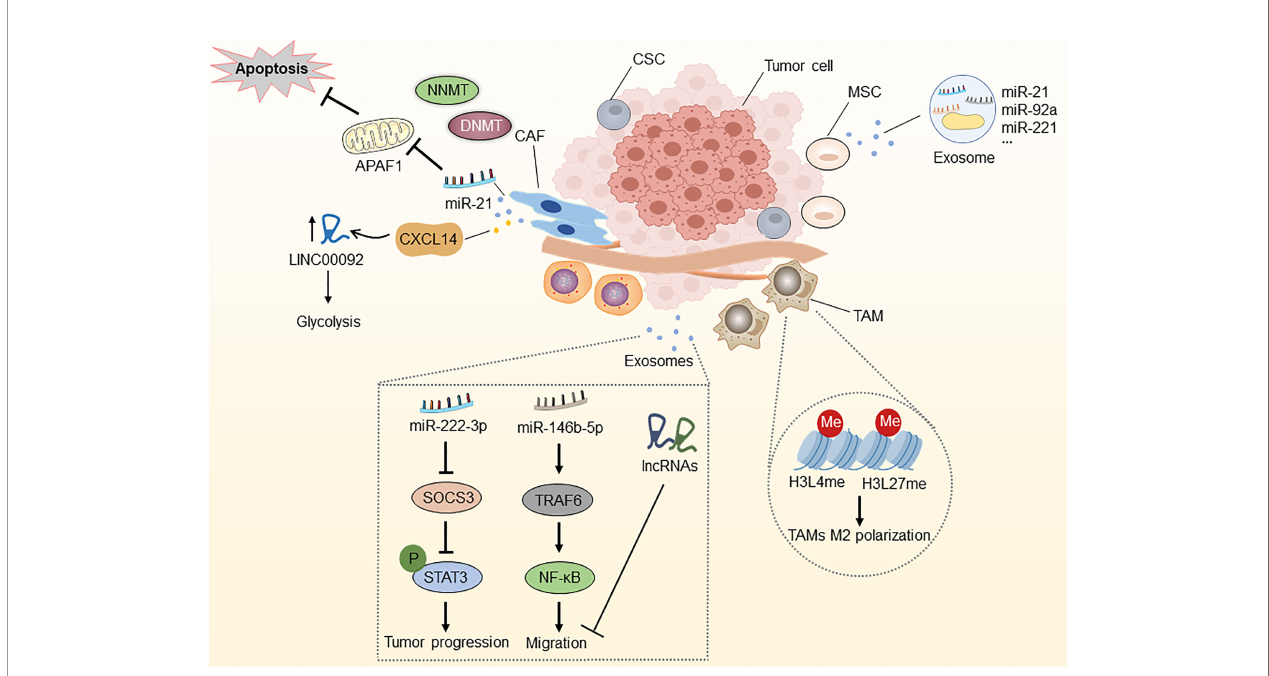
FIGURE 4 | Epigenetic modi fi cations in the tumor microenvironment. NNMT can diminish histone methylation in CAFs, and CAFs secrete miR-21 and CXCL14, which enhance OC development, metastasis, and therapy resistance. MiR-21, miR-92a, and miR-221, which are abundant in MSC-derived exosomes, are associated with OC development. Epigenetic alterations in histone H3 lysine4 and histone H3 lysine27 methylation in TAMs can induce macrophage M2 polarization. Epithelial ovarian cancer (EOC)-released exosomal miRNAs and lncRNAs via the SOCS3/STAT3 pathway and miR-146b-5P/TRAF6/NF- k B/MMP2 pathway regulate the progression, migration and drug resistance of OC. CAF, cancer-associated fi broblast; MSC, mesenchymal stem cell; TAM, tumor-associated macrophage; CSC, cancer stem cell; NNMT, nicotinamide N-methyltransferase; DNMT, DNA methyltransferase; APAF1, apoptosis protease activator-1; APAF6, TNF receptor associated factor